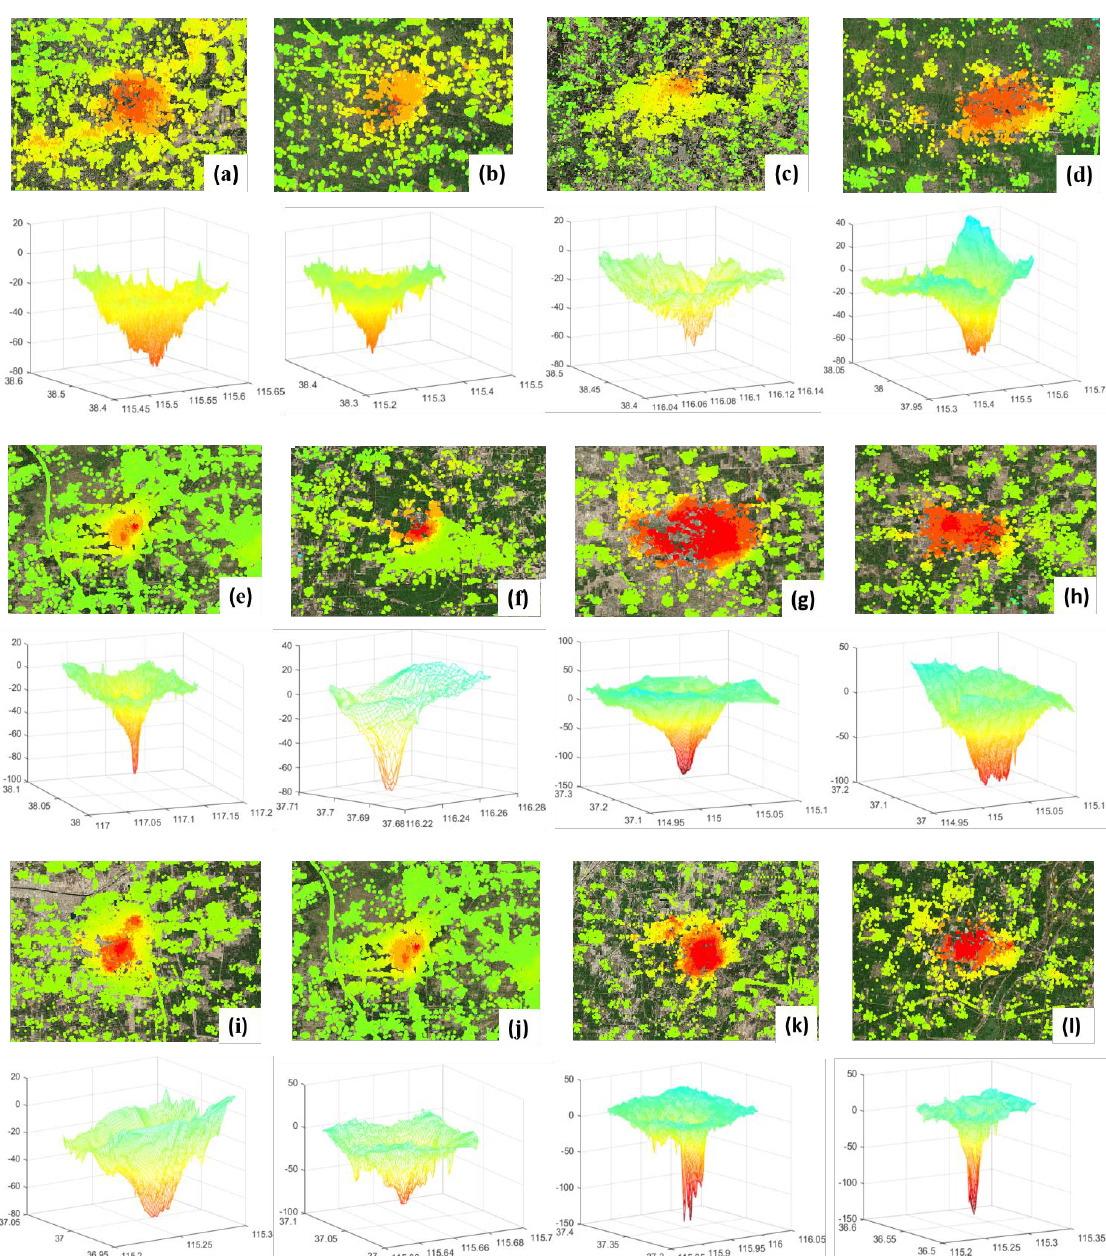
Figure 13. The subsidence center and its 3D subsidence bowl distribution for 12 counties in Hebei region, and ( a – l ) Lixian, Anguo, Hejian, Shenzhou, Mengchun, Jingxian, Julu, Pingxiang, Weixian, Qinghe, Qucheng, and Guantao,